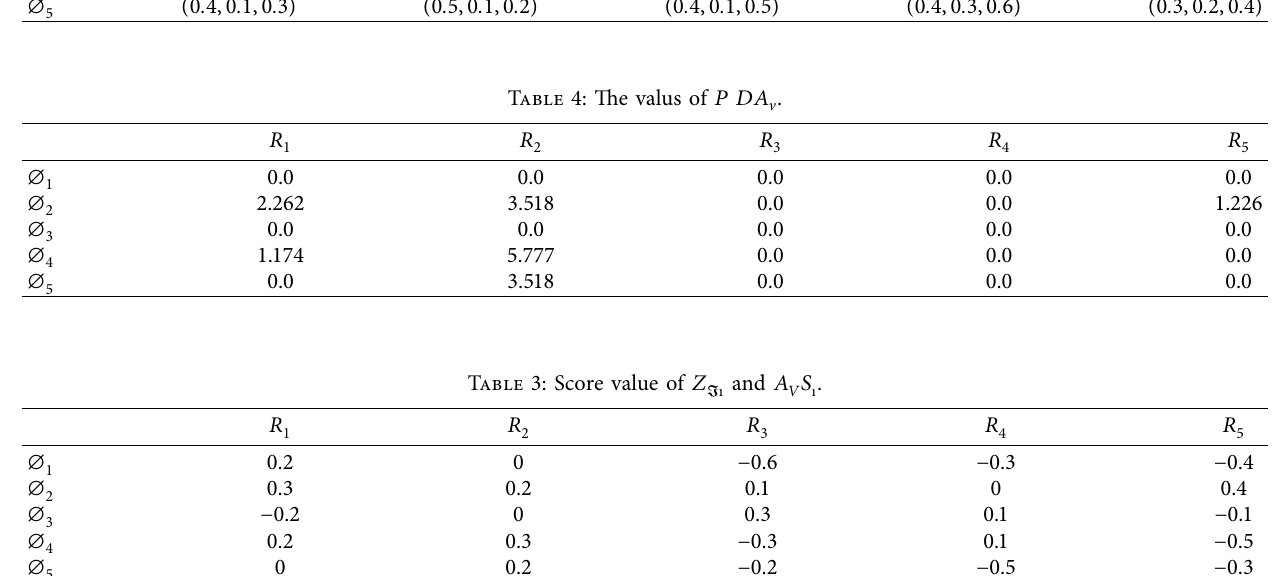
Table 4: +e valus of P DA